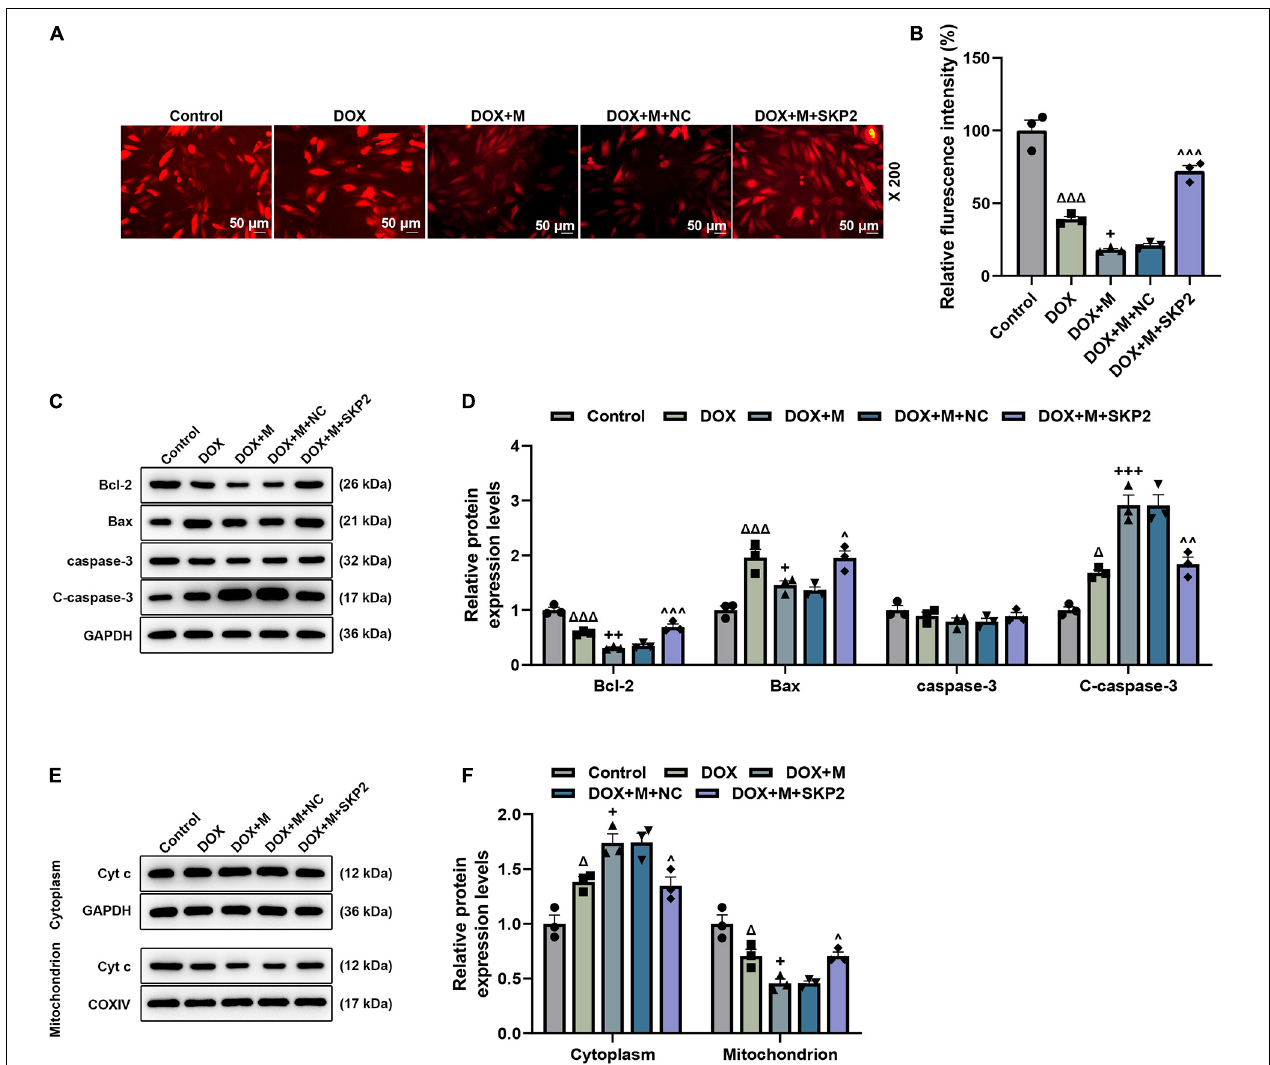
FIGURE 8 | SKP2 overexpression increased the MMP and regulated the apoptosis-related factors in miR-21-5p-treated DOX-induced cardiomyocytes. (A,B) The MMP in the miR-21-5p-treated DOX-induced H9c2 cells was determined based on the assay of TMRM staining (Magnification: × 200). (C,D) The expression of Bcl-2, Bax, and C-caspase-3 in the miR-21-5p-treated DOX-induced H9c2 cells was calculated by Western blot. GAPDH served as an internal control. (E,F) The expression of cytoplasm or mitochondrion Cyt c in the miR-21-5p-treated DOX-induced H9c2 cells was detected via Western blot. GAPDH served as an internal control for cytoplasm Cyt c, and COXIV was used as an internal control for mitochondrion Cyt c. (cid:49) P < 0.05, (cid:49) (cid:49) (cid:49) P < 0.001 vs. Control; + P < 0.05, ++ P < 0.01, +++ P < 0.001 vs. DOX; ∧ P < 0.05, ∧∧ P < 0.01, ∧∧∧ P < 0.001 vs. DOX + M + NC. DOX, doxorubicin; MMP, mitochondrial membrane potential; M, miR-21-5p mimic; NC, negative